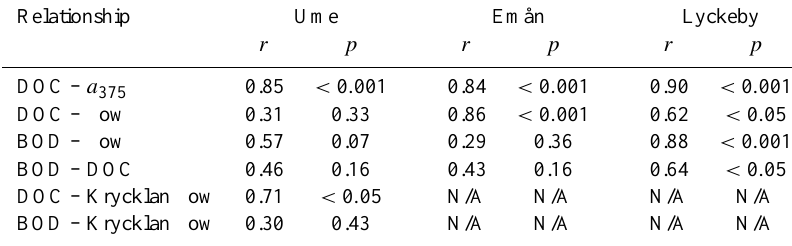
Table 3. Correlation statistics for various catchment characteristics. Relationship